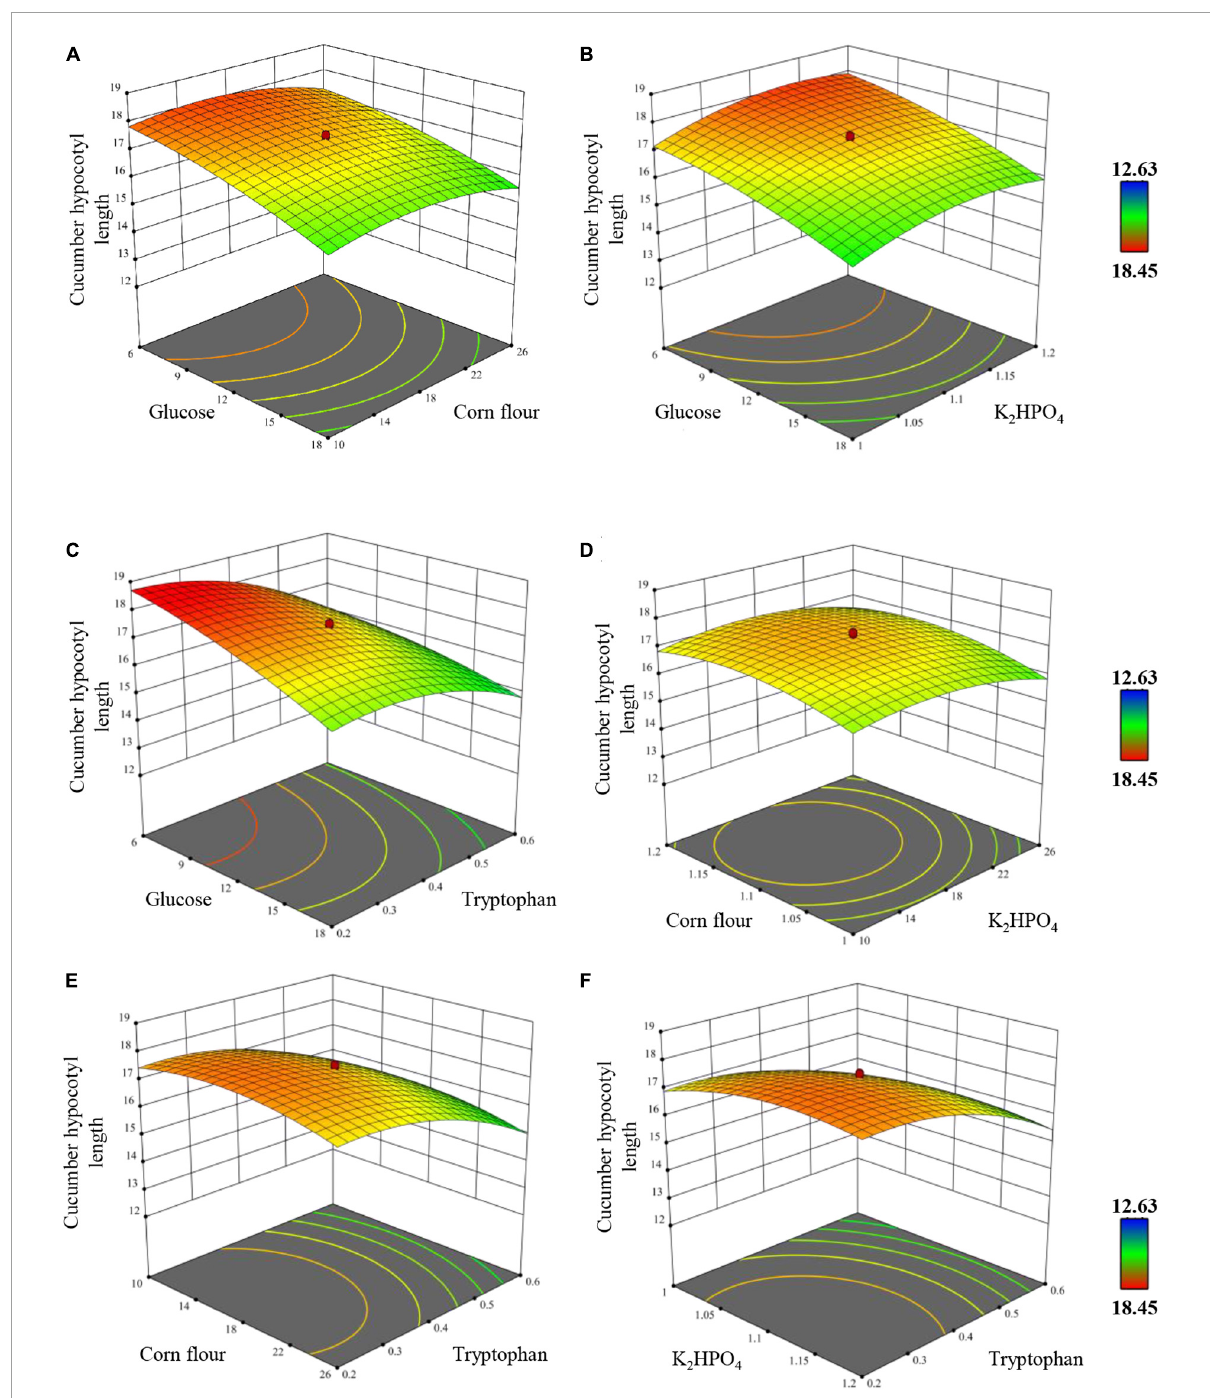
FIGURE5 Response surface and contour plot exhibiting the overall effects of (A) corn flour vs. glucose, (B) K 2 HPO 4 vs. glucose, (C) tryptophan vs. glucose, (D) K 2 HPO 4 vs. corn flour, (E) tryptophan vs. corn flour, (F) tryptophan vs. K 2 HPO 4 on the hypocotyl length of cucumber plantlets in vitro . Only tryptophan vs. glucose interaction is significant at p -value of <